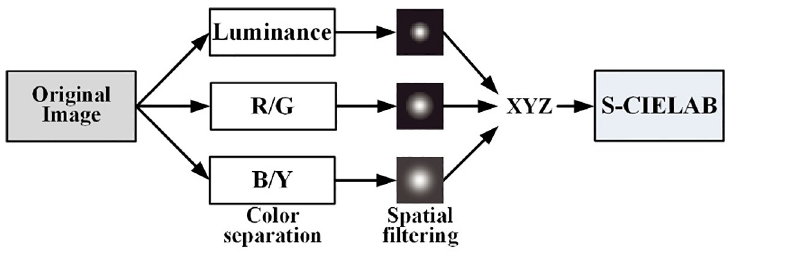
Fig 4. S-CIELAB model.